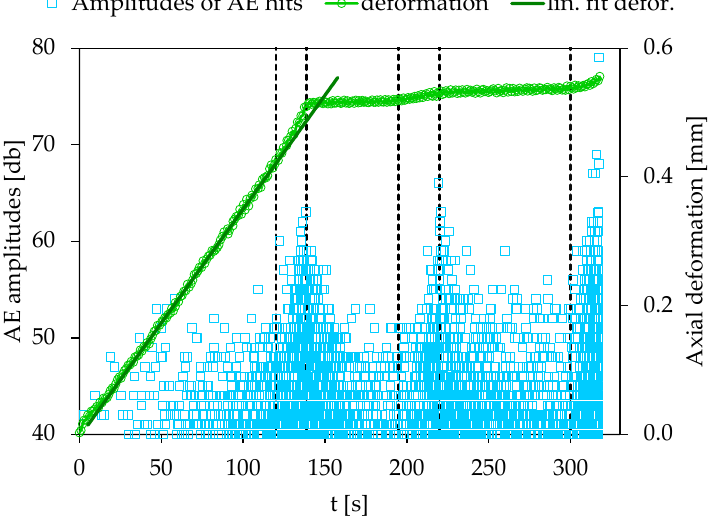
Figure 3. The temporal variation of the AE hit amplitudes and the axial deformation variation, depicted with respect to time.